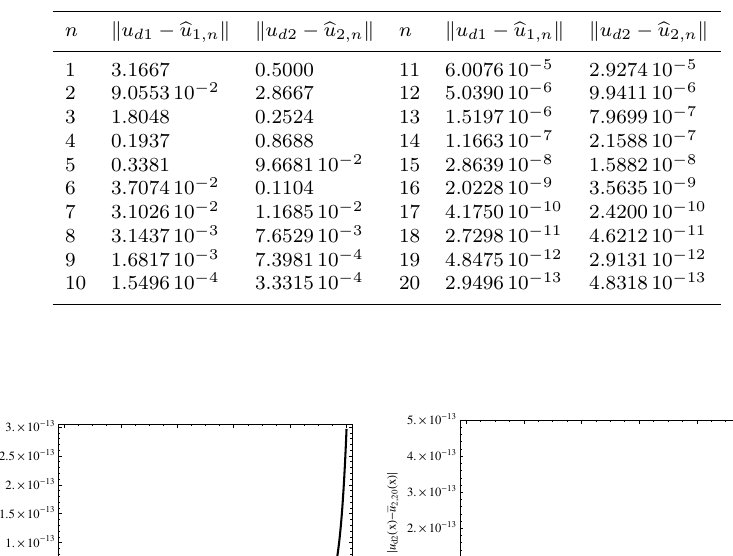
Table 3. Errors of approximations of the exact solution